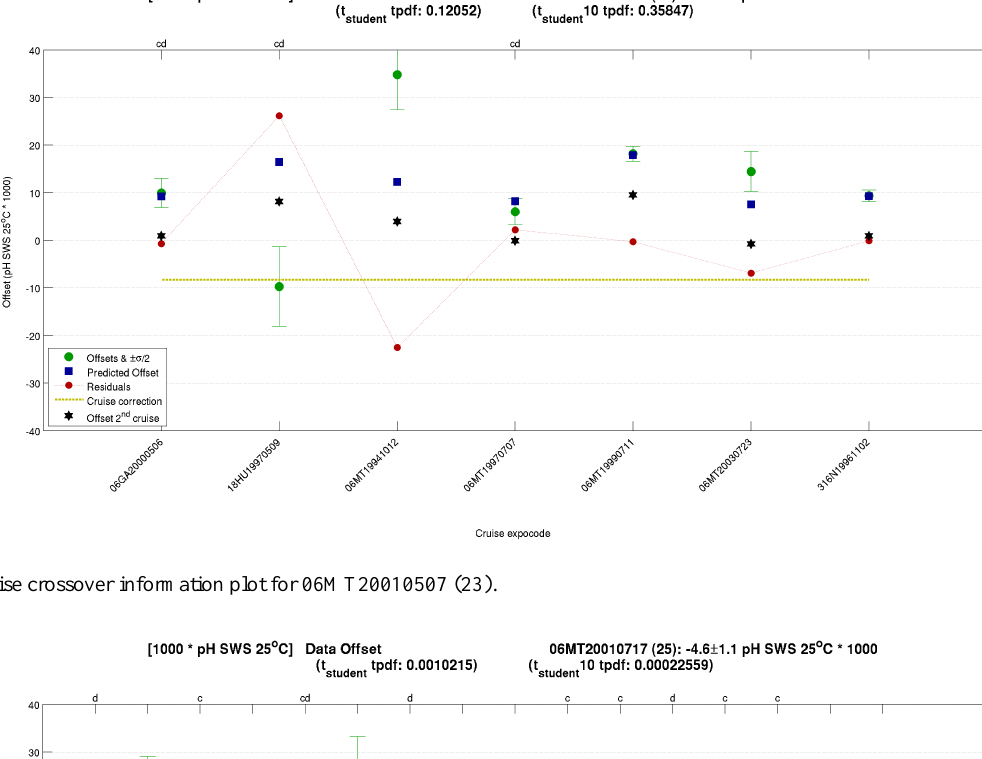
Figure 6. Cruise crossover information plot for 06MT20010507 (23).